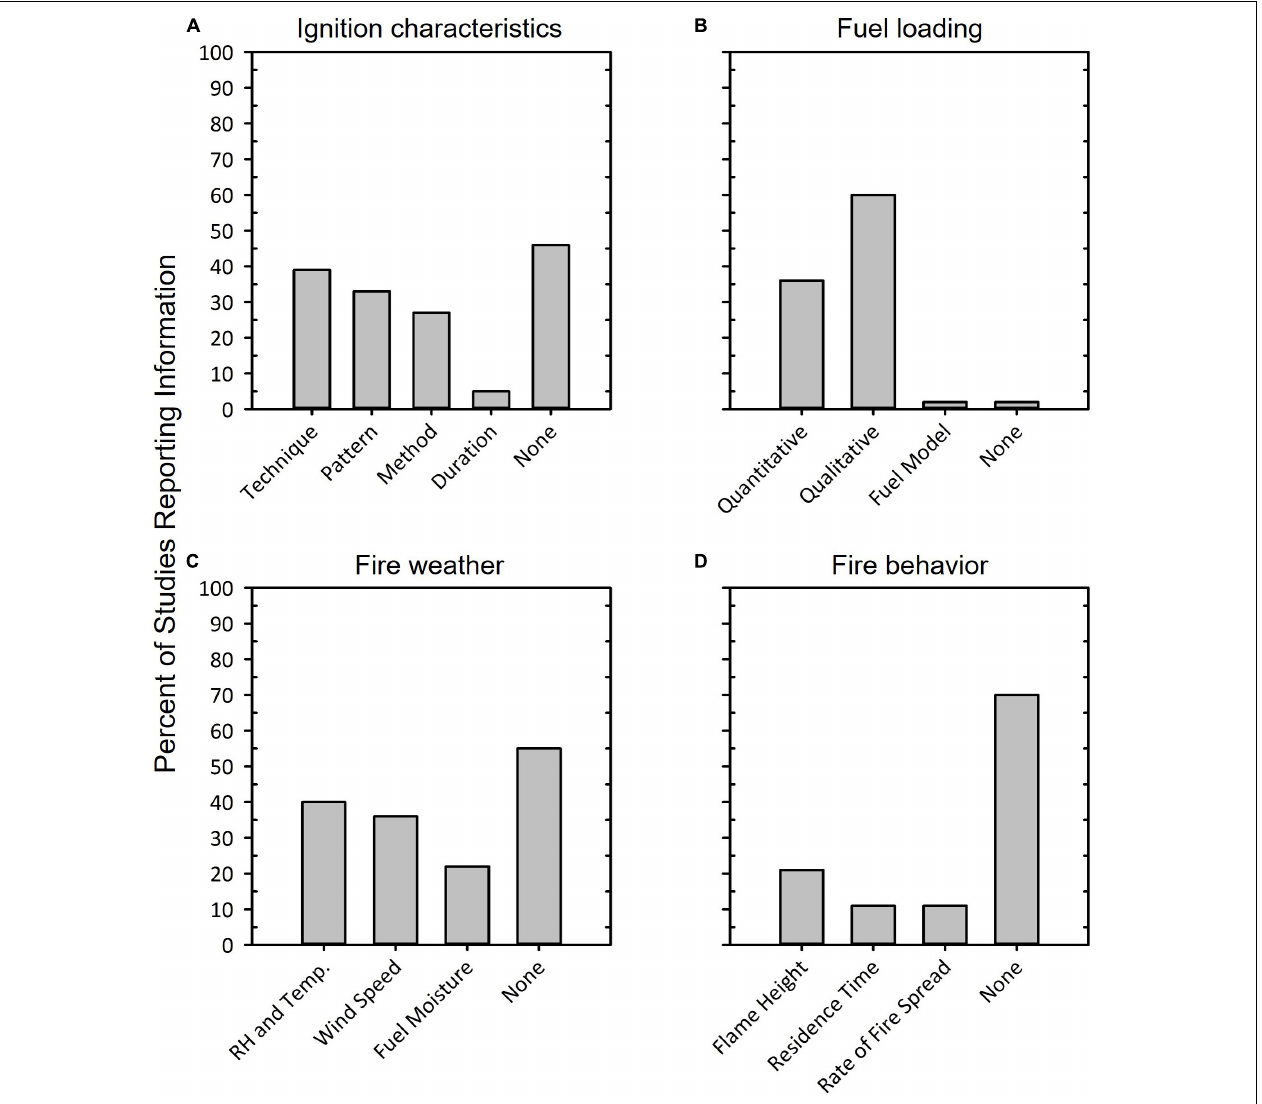
FIGURE 3 | Plots showing the level of detail to which authors reported (A) ignition characteristics, (B) fuel loading, (C) fire weather, and (D) fire behavior in recent prescribed fire